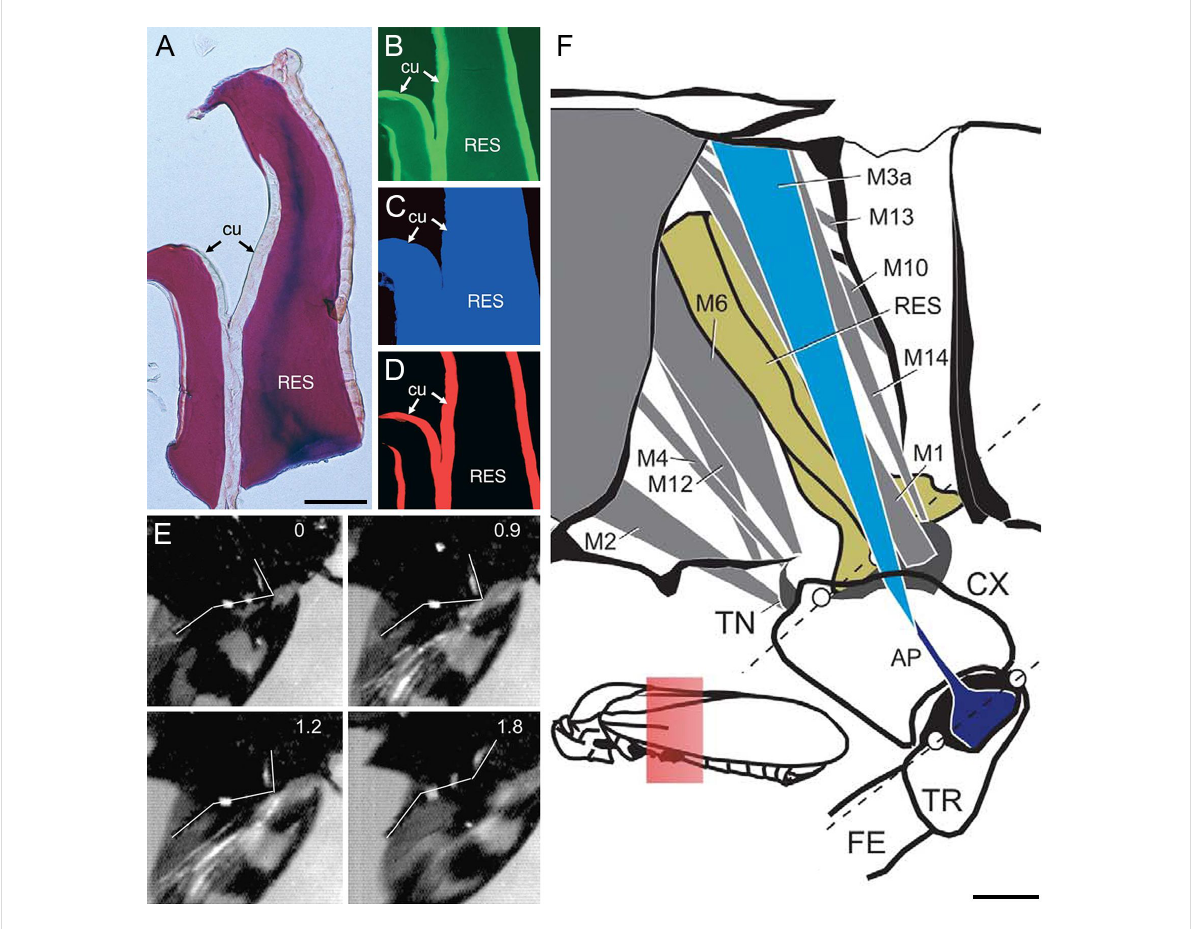
Figure 4: Resilin in the jumping system of the black-and-red froghopper ( Cercopis vulnerata ). (A–D) Cuticle supplemented with resilin in the pleural area of the metathorax. Horizontal sections through the pleural seam. (A) Paraffin-embedded cuticle stained after Cason. Bright-field micrograph. (B–D) Frozen sections of the structures shown in A. Wide-field fluorescence micrographs showing different autofluorescences exhibited by the exoskeleton. (B) Excitation: 512–546 nm; emission: 600–640 nm. (C) Excitation: 340–380 nm; emission: 420 nm. (D) Excitation: 710–775 nm; emis- sion: 810–890 nm. cu, tanned cuticle; RES, structures containing resilin. (E) Sequence of single frames of a high-speed video recording of the cicada jump (ventral aspect). The numbers indicate the time scale in milliseconds. The approximate positions of femur, tibia and tarsus are indicated by white lines according to white marker dots on the leg. (F) Skeleton-muscle organisation of the cicada metathorax (medial aspect, right side). AP, apodeme of the trochanter extensor muscle M3; CX, coxa; FE, femur; M1, M2, M4, M6, M14, subcoxal muscles; M7, M9, M10, M11, M12, M13, M14, meta- thoracic muscles; M5, trigger muscle; M8a, M8b, trochanter flexor muscle; RES, resilin; TN, trochantine; TR, trochanter; white circles, condyli of the coxa and trochanter. The inset shows the position of the structures in the entire insect body. (A–F) Adapted with permission from [16], copyright 2004